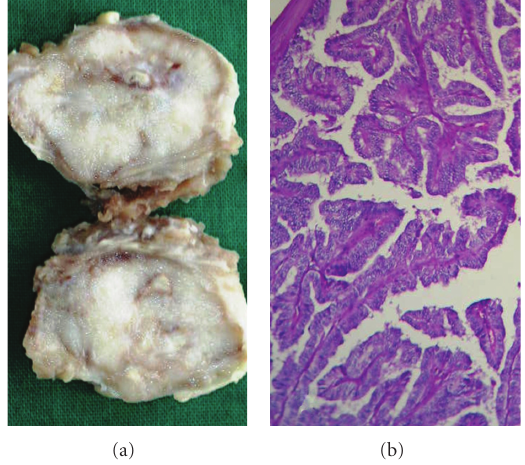
Figure 2: (a) Nodule excised from the thigh showing gray white solid areas with papillary excrescences. (b) Sections from the thigh nodule show papillary structures with ground glass nuclei